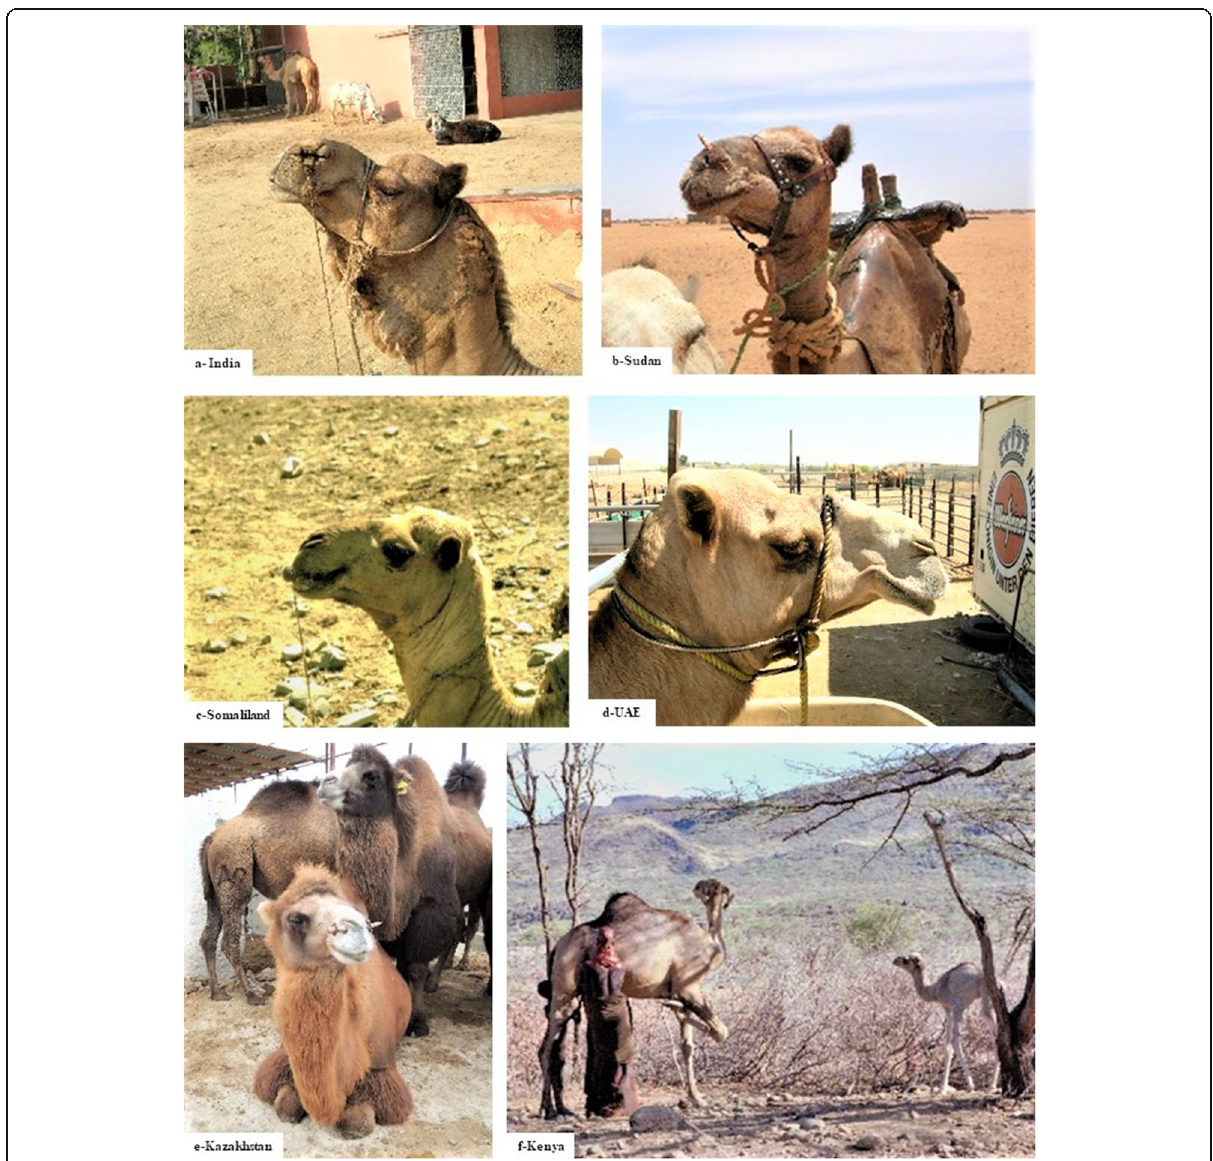
Fig. 4 Images of various camel restraints and control practices used by nomadic camel pastoralists in a variety of countries (Dioli 2012, 2013, Schwartz and Dioli 1992). a India. b Sudan. c Somaliland. d UAE. e Kazakhstan. f